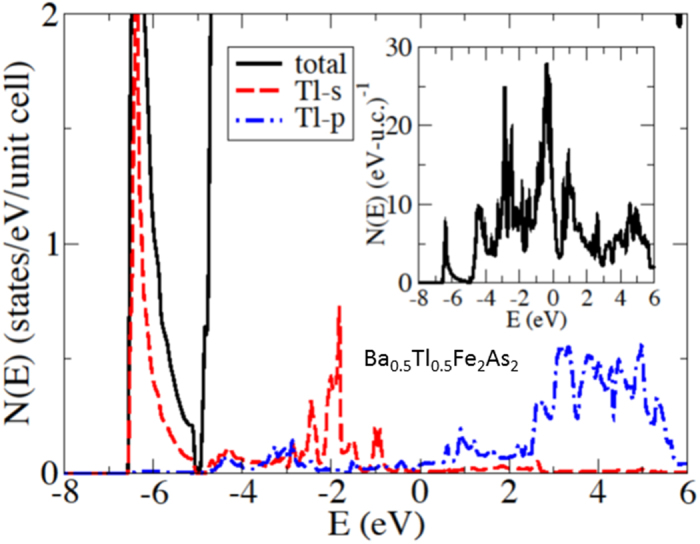
The calculated non-magnetic density-of-states of a Ba0.5Tl0.5Fe2As2 cell, demonstrating the monovalency of Tl in this structure (see text).